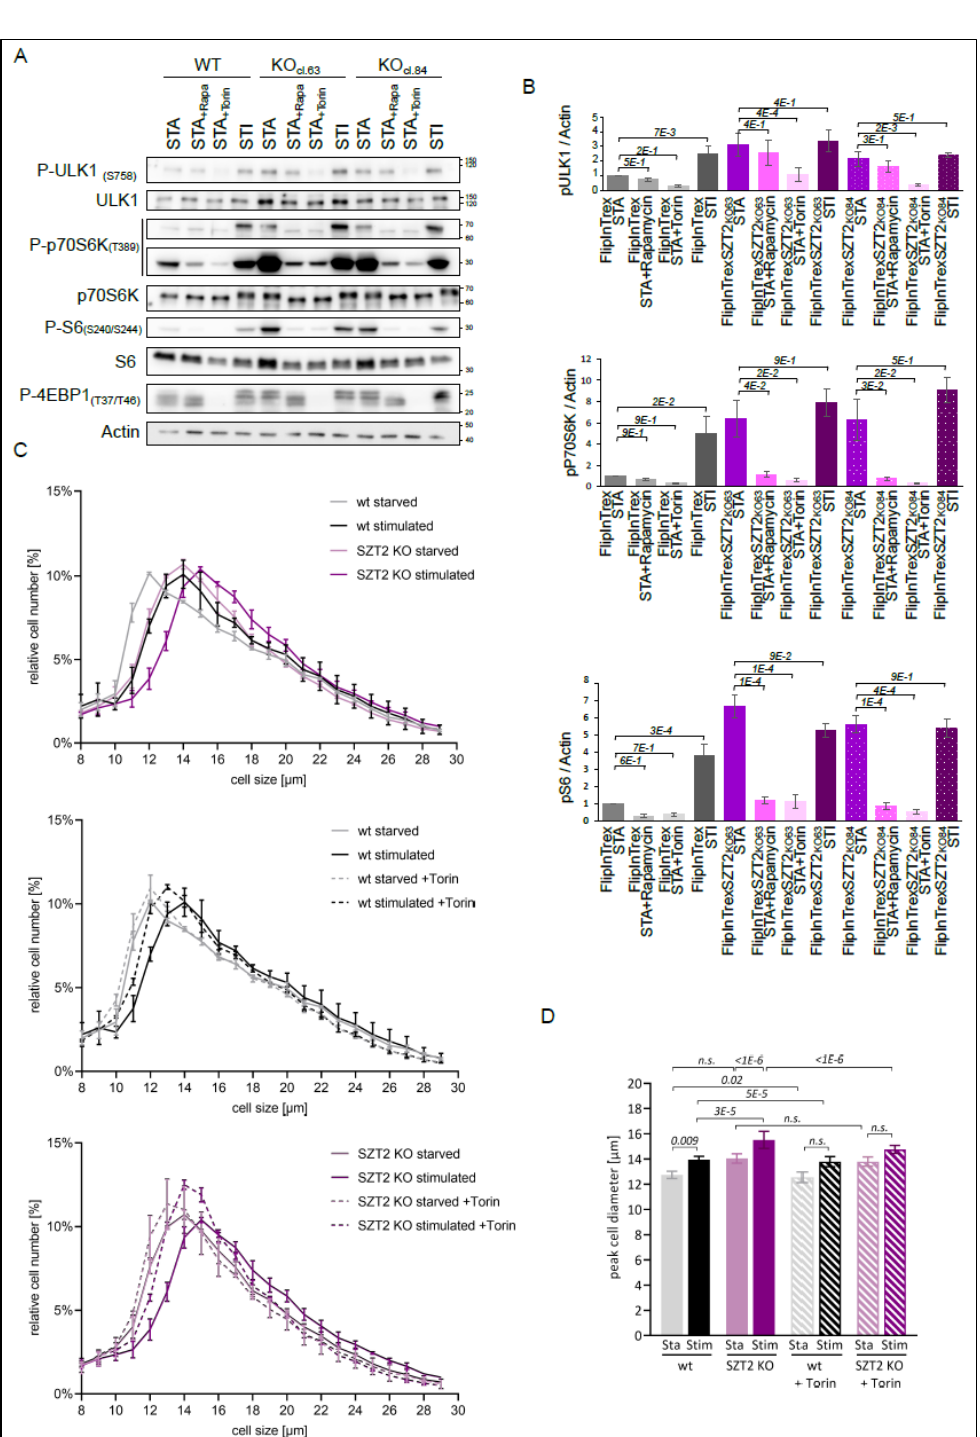
Figure 5 . Torin and Rapamycin reduce the mTORC1 hyperactivity seen in SZT2 KO cells. ( A ) Wild type and SZT2 KO cells were starved for amino acids for 1 h followed or not by restimulation for 20 min. In addition, cells were treated with either Rapamycin or Torin during starvation. Obtained lysates were separated by SDS-PAGE and the presence of the indicated proteins determined by immunoblotting. Data are representative of three independent experiments. ( B ) Analysis of the reg- ulation of selected proteins detected in (A). Graphics display the mean + SEM. ( C ) Control and SZT2 KO cells were starved for amino acids for 3 h and restimulated for another 3 h prior to harvesting. The cell diameter of three biological replicates per cell line and condition were analyzed. Graphics represent the cell size of at least 45,000 viable cells per condition plotted against their relative number ± standard dev. ( D ) Quantification of the peak cell diameter of each cell line analyzed in ( C ). Graphic represents the peak diameter in the different conditions ± standard dev. The statistical significance was analyzed using a nonparametric Kruskal –Wallis test and subsequent Dunn’s test w ith the p -value depicted in italics.